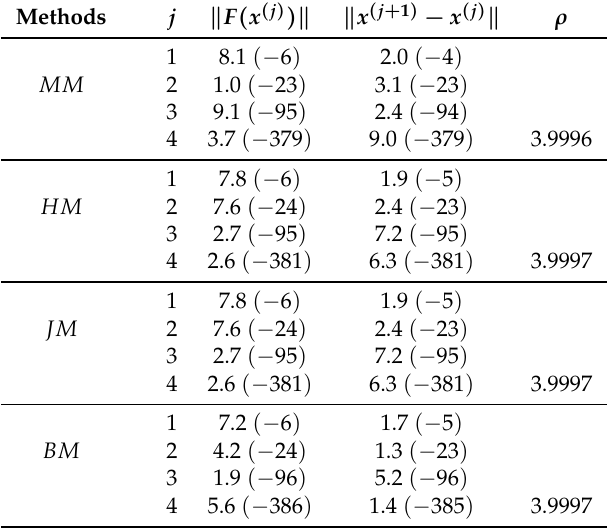
Table 6. Convergence behavior of distinct fourth-order methods for Example